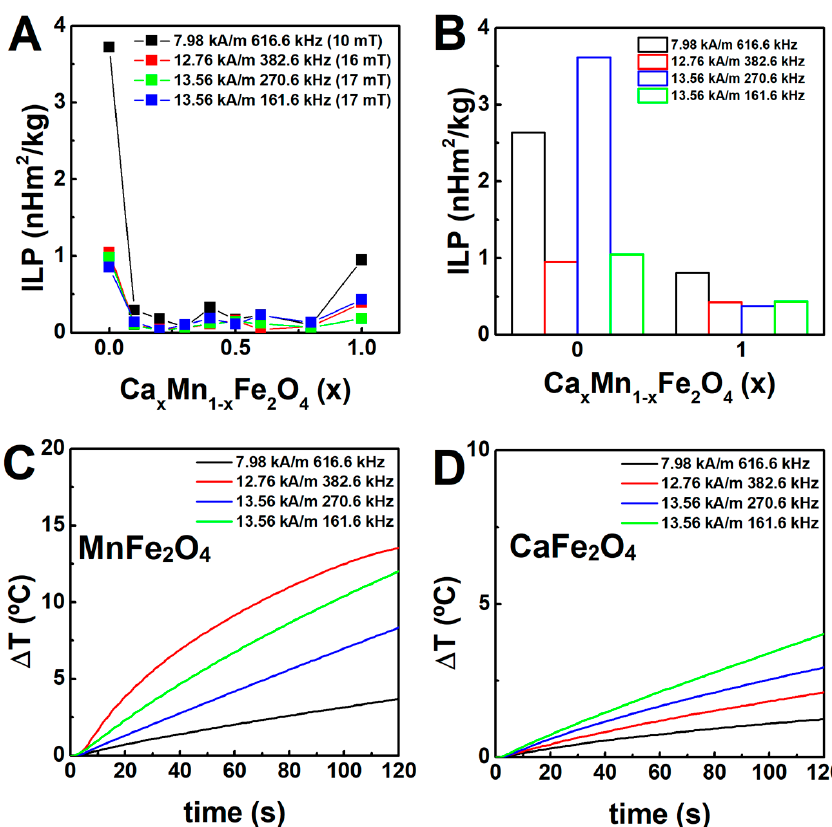
Figure 7. ( A ) Dependence of the intrinsic loss power (ILP) on the composition of the nanoparticles at 5 mg/mL. ( B ) ILP and ( C , D ) temperature variation over time of the manganese and calcium-doped ferrites obtained through synthesis at 100 °C. The equivalent magnetic flux density is also indicated in brackets.